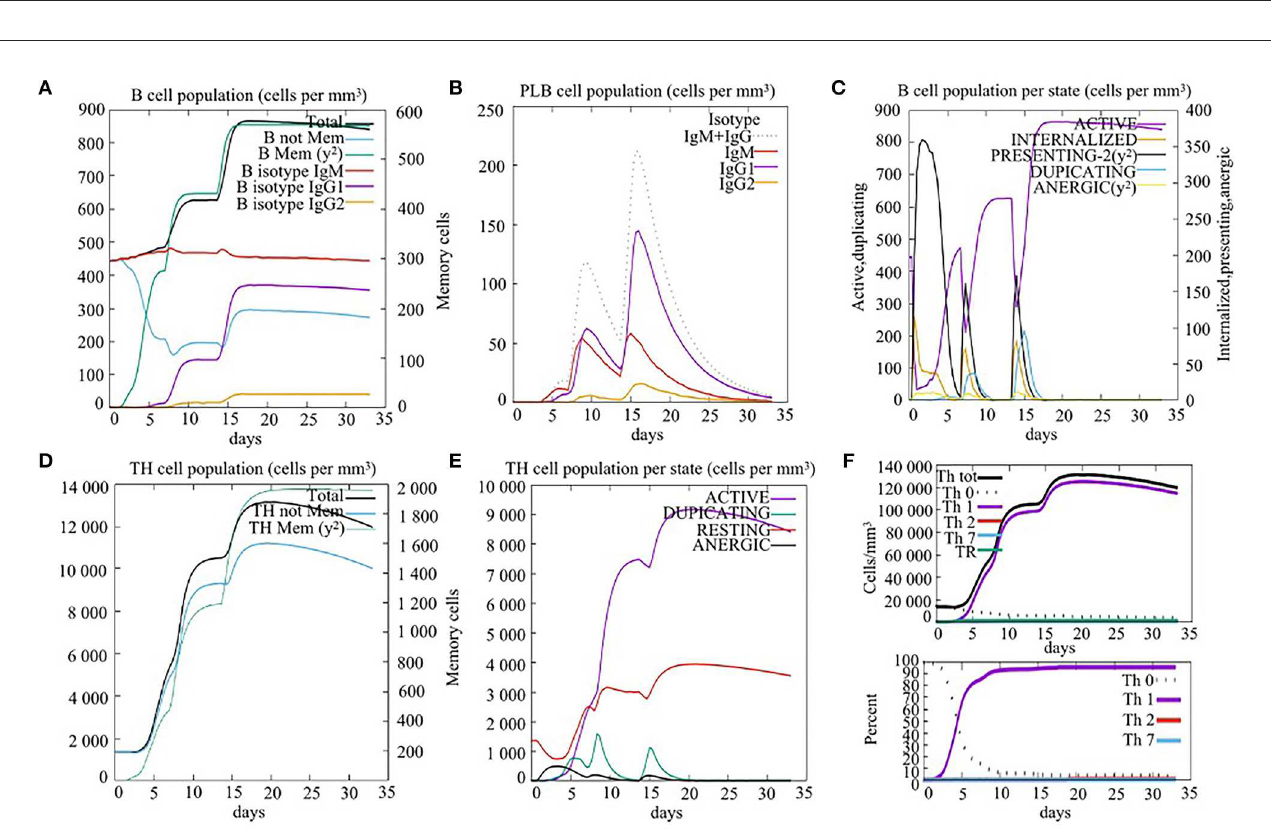
FIGURE9 B cell and Th counts shown in silico immune simulation. (A) B lymphocytes, total count, memory cells, and sub-divided in isotypes IgM, IgG1 and IgG2; (B) Plasma B lymphocytes count sub-divided per isotype (IgM, IgG1 and IgG2); (C) B lymphocytes population per entity-state (i.e, showing counts for active, presenting on class-II, internalized the Ag, duplicating and anergic; (D) CD4 T-helper lymphocytes count. The plot shows total and memory counts; (E) CD4 T-helper lymphocytes count sub-divided per entity-state (i.e., acctive, resting, anergic and duplicating); (F) CD4 T-regulatory lymphocytes count. Both total, memory and per entity-state counts are plotted here. Act, active; Intern, internalized the Ag; Pres II, presenting on MHC II; Dup, in the mitotic cycle; Anergic, anergic; Resting, not